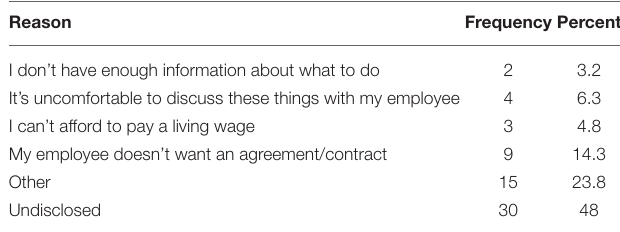
TABLE 4 | Difficulties experienced in offering benefits or living wages to